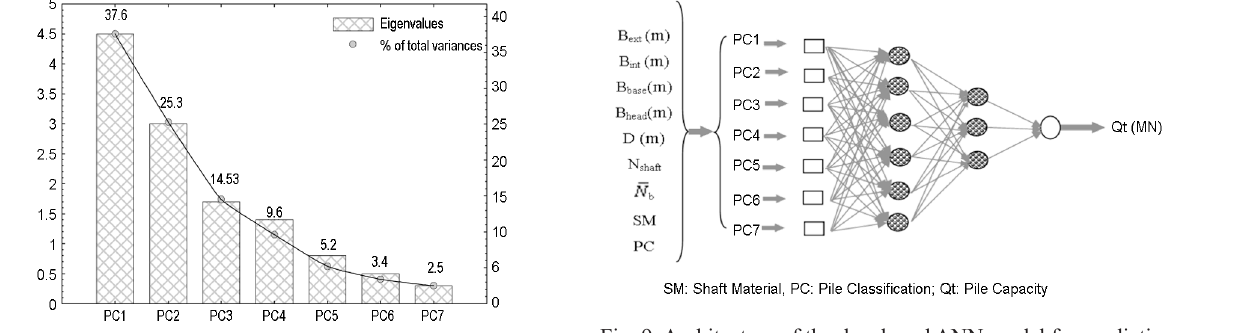
total variation